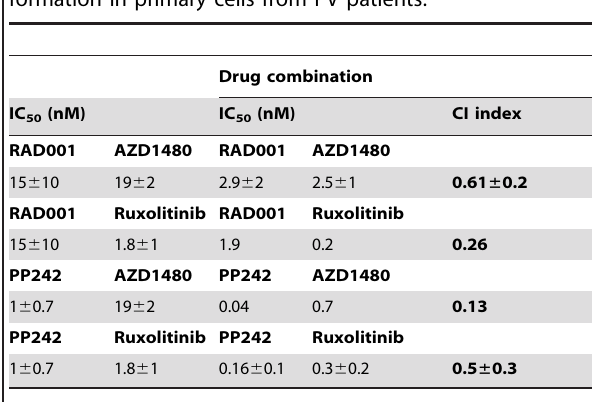
Table 4. Combination of mTOR and JAK2 inhibitor resulted synergistic in reducing erythropoietin-independent colony formation in primary cells from PV